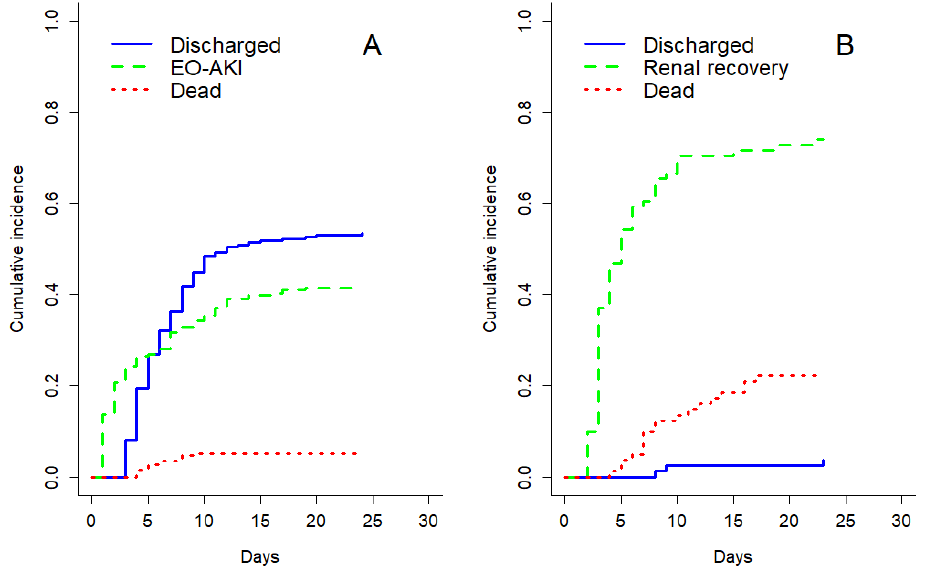
Figure 2. Cumulative incidence of early-onset acute kidney injury (EO-AKI) ( A ) and renal recovery ( B ) taking into account competing risks of discharge alive and mortality.